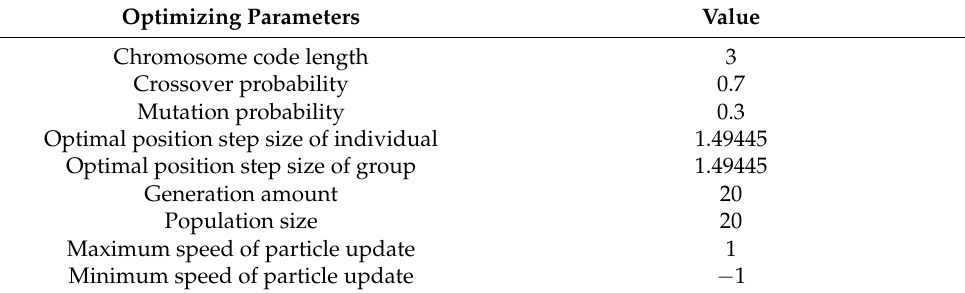
Table 1. GA-PSO parameters.